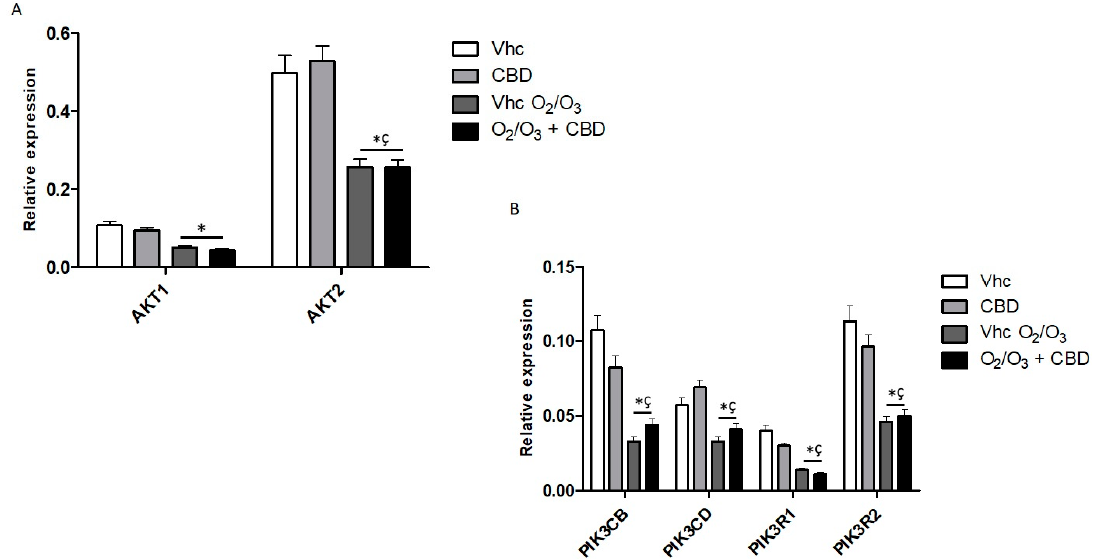
Figure 14. Modulation of PI3K/AKT pathway in PANC-1 cell line. ( A ) AKT1 and AKT2 mRNA expression and ( B ) PIK3CB , PIK3CD , PIK3R1 and PIK3R2 mRNA expression was evaluated by qRT-PCR in PANC-1 cell line, treated with CBD in presence and absence of O 2 / O 3 . Target mRNA levels were normalized for GAPDH expression. Data are expressed as fold mean ± SE. * p < 0.05 vs. Vhc, #, * p < 0.05 vs. Vhc O 2 / O 3 , ç p < 0.05 vs. CBD.